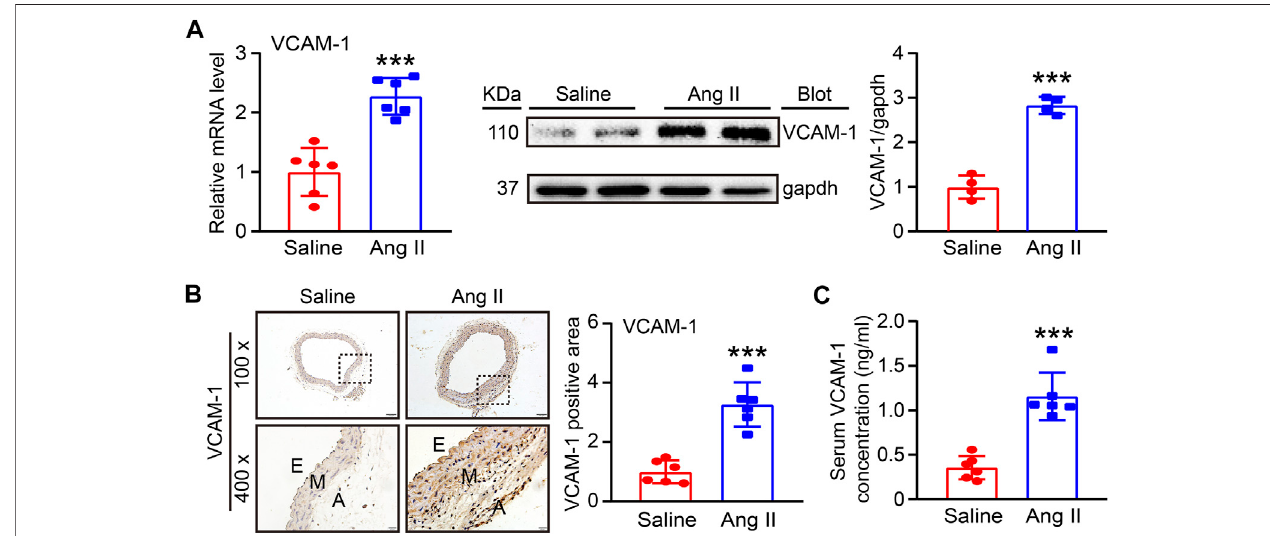
FIGURE1| AngIIinfusionelevatesVCAM-1levelsintheaorta. (A) WTmicewereinfusedwithAngII(490 ng kg − 1 min − 1 )orsalinefor14 days.qPCRanalysisofthe VCAM-1 mRNA level in the aorta ( n = 6), immunoblot analysis of VCAM-1 expression in the aorta (left) and quanti fi cation of the levels of this protein (right, n = 4). (B) ImmunohistochemicalstainingofarterialtissuewithaVCAM-1antibodyat100x(upper,scalebar=100 μ m)and400x(lower,scalebar=20 μ m)andquanti fi cationofthe VCAM-1-positivearea(right, n =6). (C) AnalysisoftheVCAM-1concentrationinmouseserum ( n =6).Thedataareexpressed asthemean±SD,and nrepresents the number of samples. *** p < 0.001 versus saline.